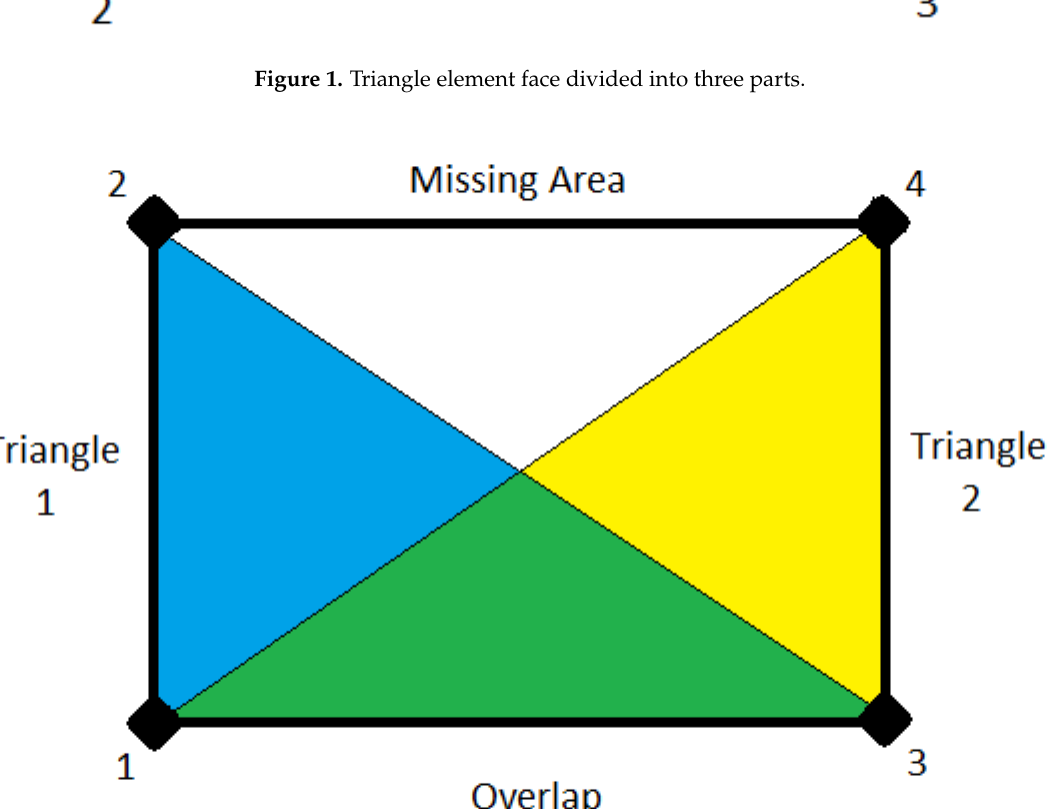
Figure 2. An example of how picking the wrong nodes to divide a quad into two triangles (blue and yellow) can cause error due to area overlap (green), utilizing nodes 1-2-3 and